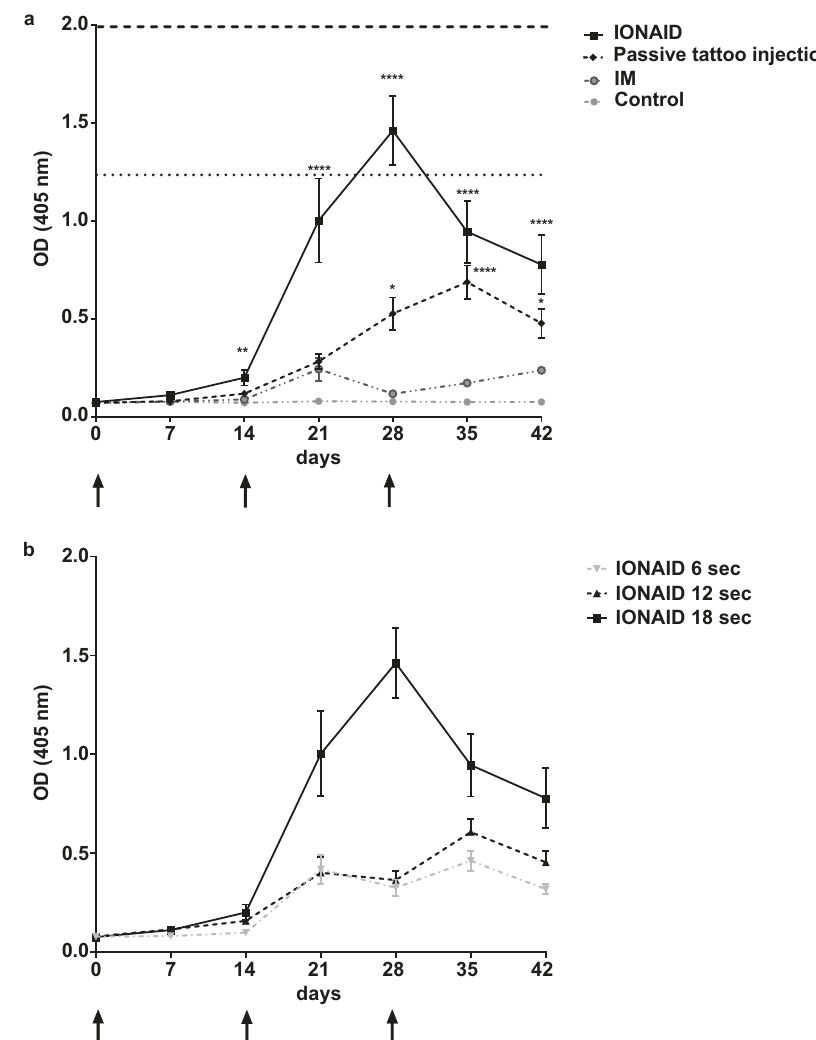
Fig. 4 ZGP-enhanced humoral immune responses by IONAID in rabbits. a ZGP IgG responses from immunized groups of rabbits ( n = 3/ group) after vaccination with 500 µg of pIDV-II-EboV-GP-M06. Antibodies responses were analyzed by ELISA at day 0 and every week post vaccination from serum samples, which were used in a 1/10,000 dilution. Results are shown as means ± SEM. The arrows indicate the days of the initial vaccination and the two boosters. Horizontal dashed lines show the range of ZGP IgG responses found in Ebola survivors and horizontal dotted lines show the range of ZGP IgG levels found in vaccinated humans. Statistical analysis was made using one-way ANOVA, followed by Tukey multiple comparisons test. Asterisks denote statistically signi fi cant data ( *P < 0.05, **P < 0.01 *** , P < 0.001, ****P < 0.0001). b In fl uence of the duration of tattooing on ZGP IgG responses from immunized groups of rabbits ( n =